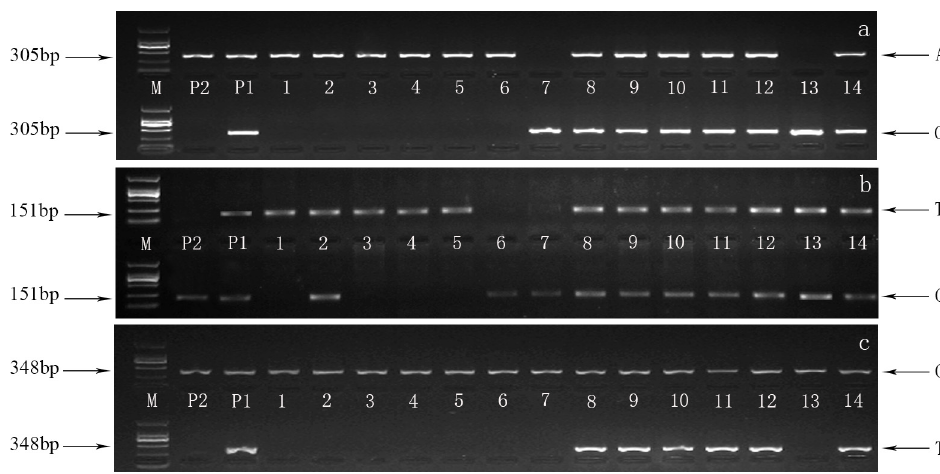
Fig 5. Agarose gel photo of the allele specific (AS) amplifications of the three markers. a, b and c PCR products of M16337, M25207 and M38412, respectively. M represents a 2000 bp marker followed by the parent lines and lanes 1 – 14 with template DNA derived from: P1 female parent, P2 male parent, 1 – 7 dwarf type individuals, 8 – 14 non-dwarf type individuals. The same samples were employed in the same order between the upper and lower band of the AS-PCRs. For the three markers, the upper band and lower band were amplified independently of the targeted SNP genotype. The corresponding tested SNP alleles are indicated in the figure.